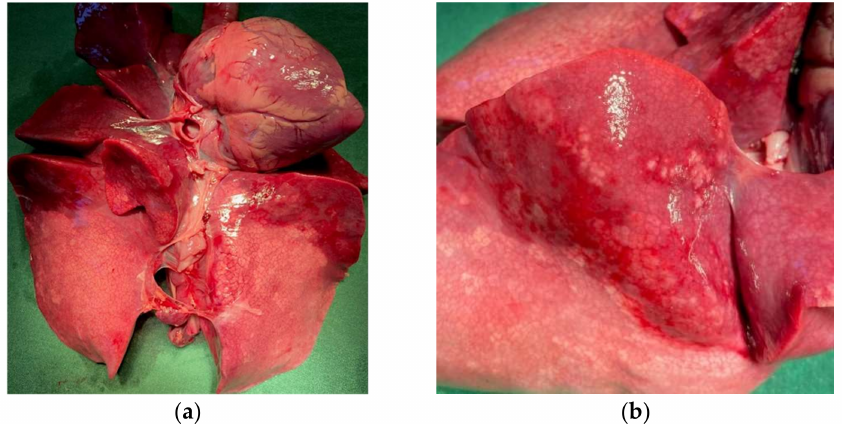
Figure 4. CCDC65 homozygous affected lamb with lung lesions. ( a ) heart-pulmonary system of an affected homozygous lamb; ( b ) magnification of hepatized lobes.